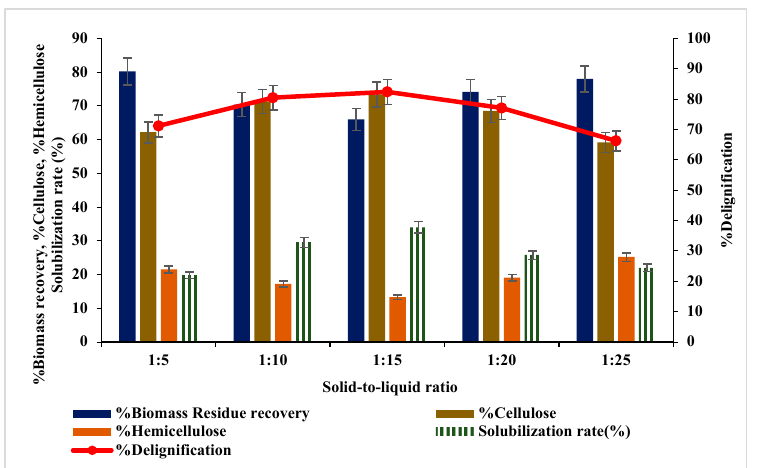
Figure 2. E ff ect of the S/L ratio on ChCl: LA-mediated pretreatment of Atriplex crassifolia. Figure 2. Effect of the S/L ratio on ChCl: LA-mediated pretreatment of Atriplex crassifolia